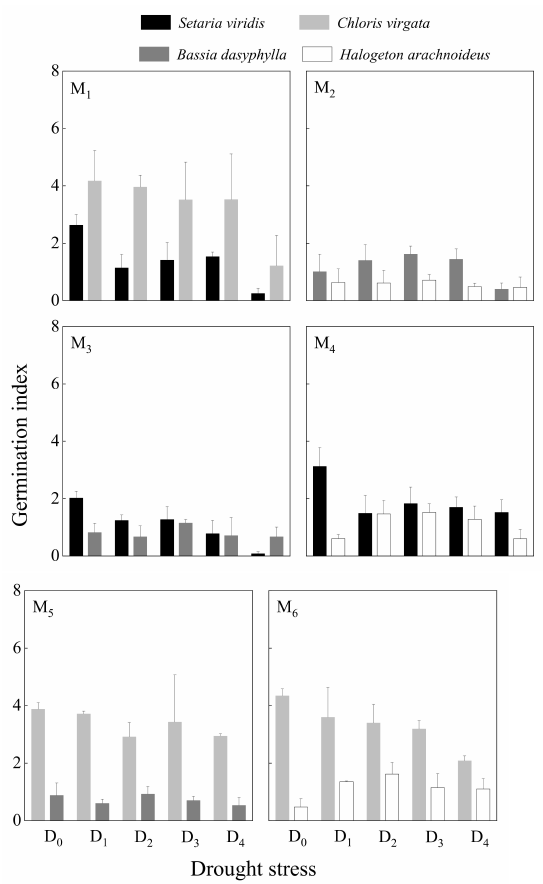
Figure 2. Response of the germination index of four annual desert plants to the interaction of drought and mixed sowing (M1–M6 represents the mixed growth combination of different plants: Setaria viridis and Saxifragon (M1), Chenopodium glaucum and white stem halophyte (M2), Setaria viridis and white stem halophyte (M3), Setaria viridis and white stem halophyte (M4), Setaria viridis and white stem halophyte (M5), Setaria viridis and white stem halophyte